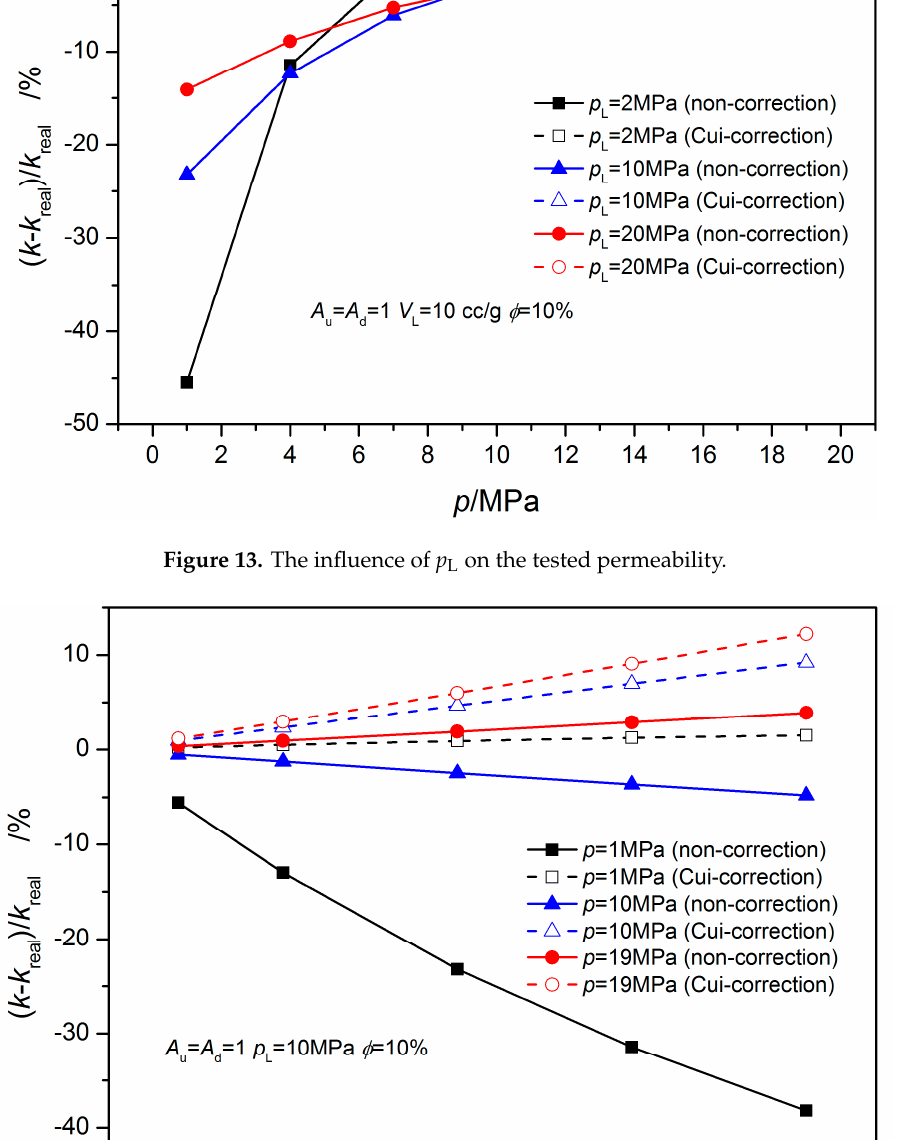
Figure 14. The influence of V L on the tested permeability.